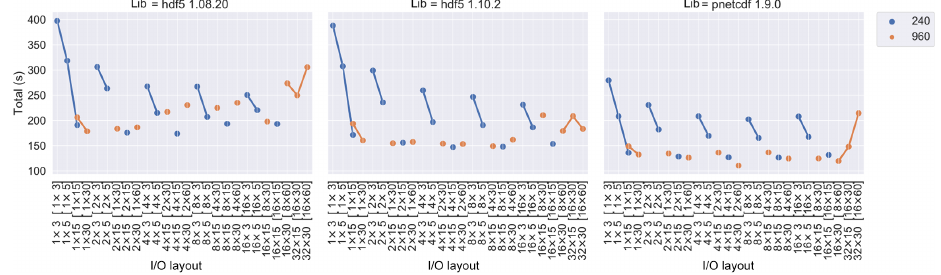
Figure 7. Total elapsed time versus I / O layout for different libraries and PE numbers. Higher contention at 960 PEs can overwhelm the overall performance trends observed at 240 PEs. The I / O layout together with its PE distribution in [PE per node × nodes] are labelled on the x axis.